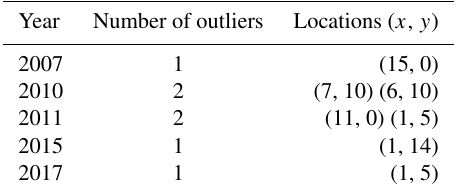
Table A1. The numbers and locations of WegenerNet outliers based on the Mahalanobis